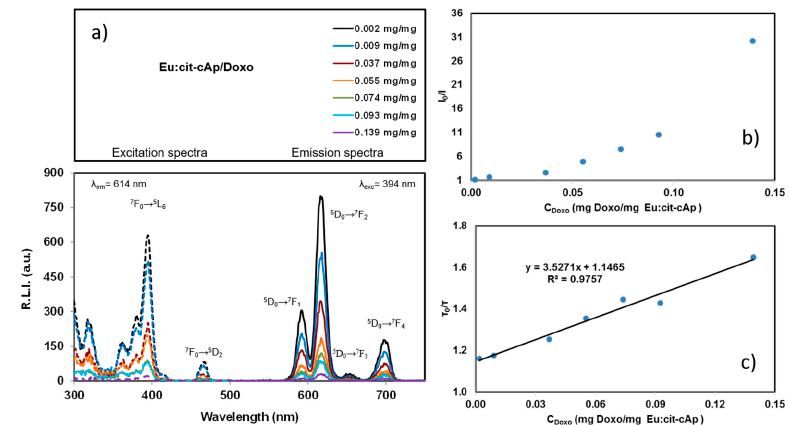
Figure 6. ( a ) excitation (dashed line) and emission (solid line) spectra of Eu:cit-cAp nanoparticles loaded with varying amounts of Doxo, in aqueous suspensions at 25 ◦ C and pH 7.4; ( b ) Stern–Volmer plot in intensity; and ( c ) Stern–Volmer plot in lifetime. λ exc / em = 394 / 614 nm, slit-widths exc / em = 10 / 10 nm,